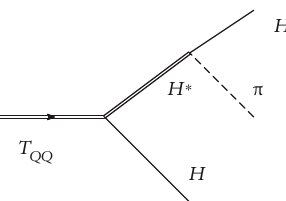
Figure 1: Typical Feynman diagram for the T